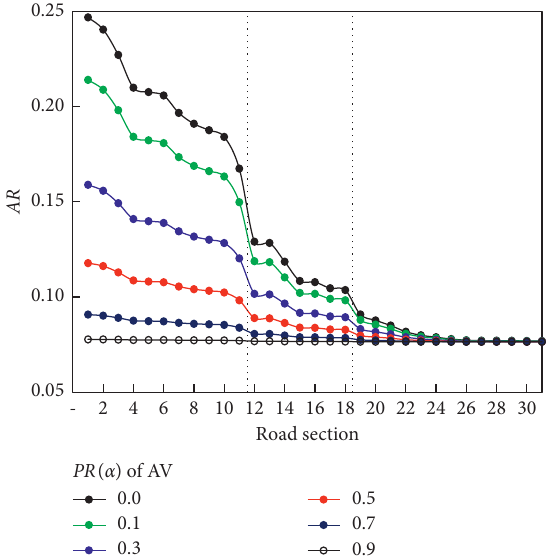
Figure 9: Effects of PR of high-level AV on the reduction of AR